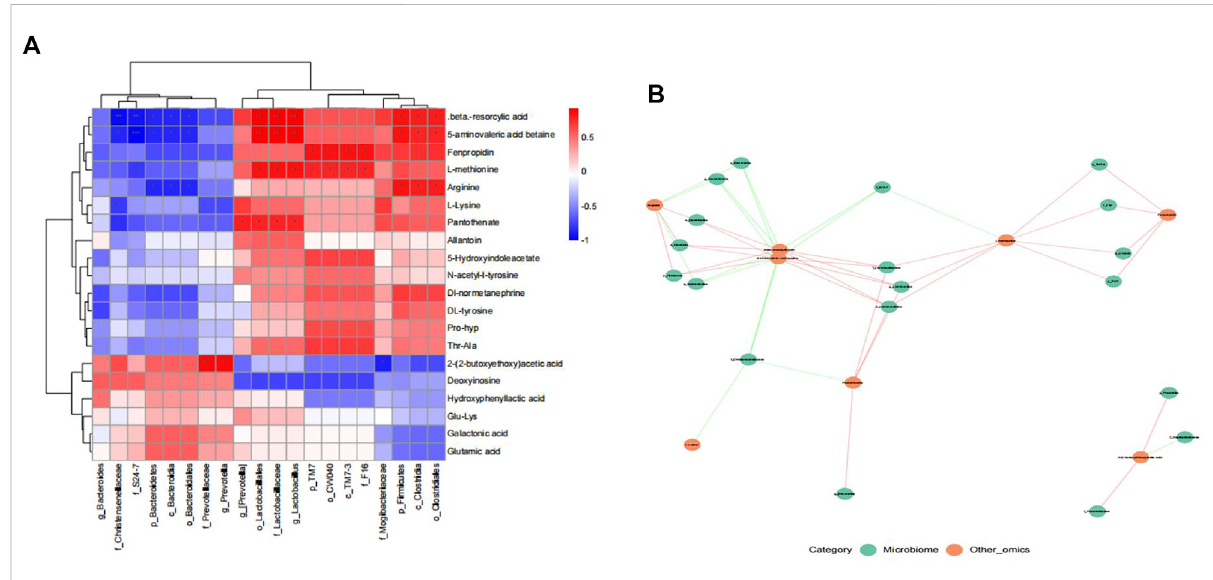
FIGURE 6 Spearman correlation analysis of microbial diversity and serum